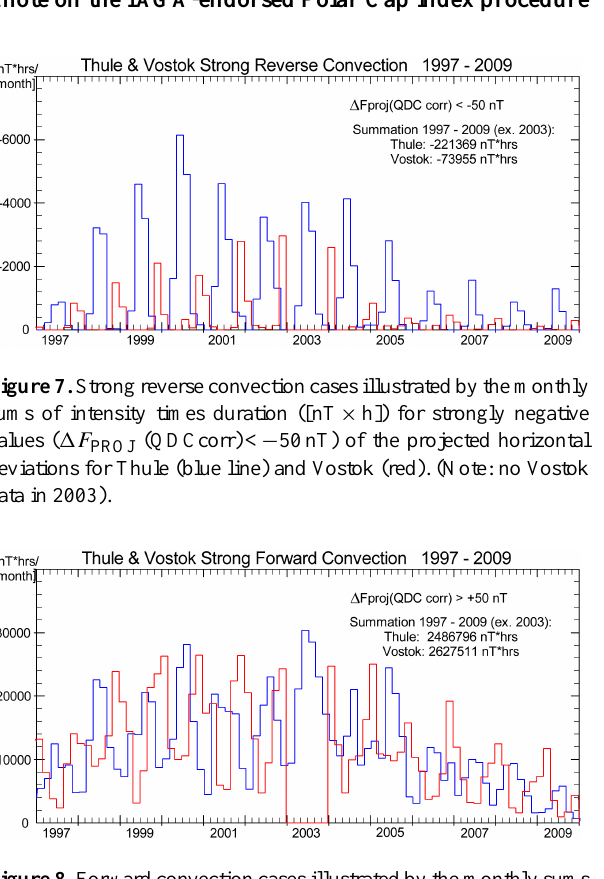
Figure 8. Forward convection cases illustrated by the monthly sums of intensity times duration [nT × h]) for strongly positive values ( (cid:49)F PROJ (QDCcorr)> + 50nT) of the projected horizontal varia- tion for Thule (blue line) and Vostok (red). (Note: no Vostok data in